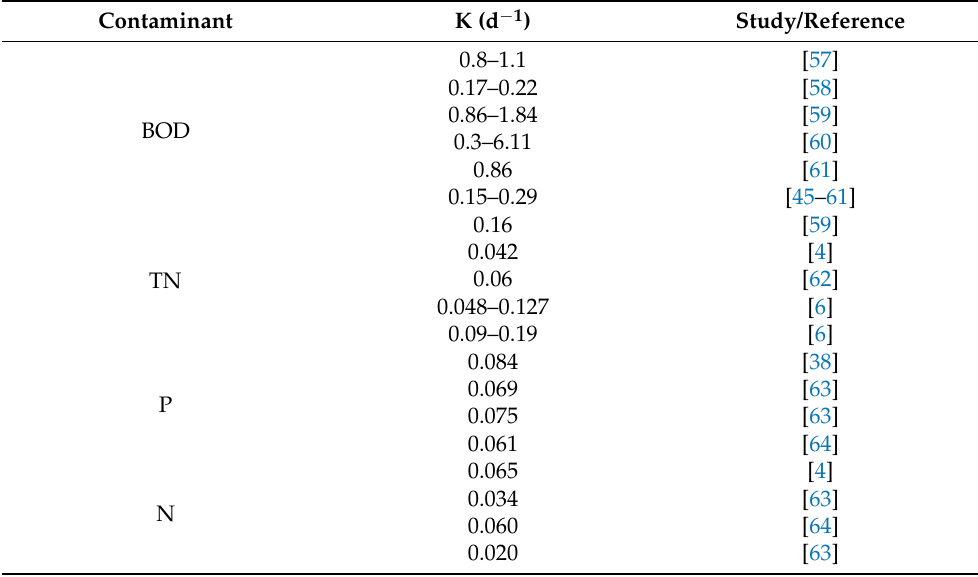
Table 2. Decay Rates for Various Contaminants for Wastewater